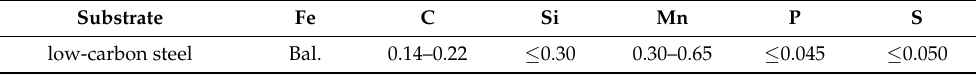
Table 2. Chemical composition of low-carbon steel (wt.